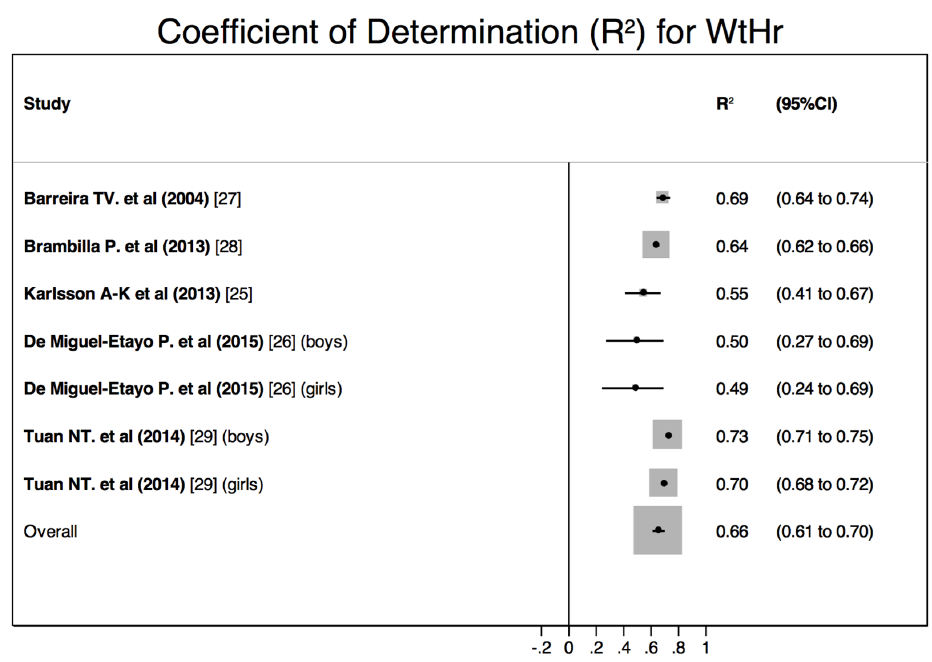
Figure 4. Results of the quantitative meta-analysis: pooled coefficient of determination ( R 2 ) for WtHr to assess BF measured by DEXA.